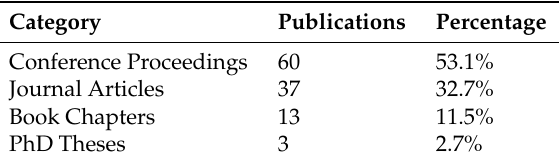
Figure 3. Number of publications per year. Table 2. Publications per